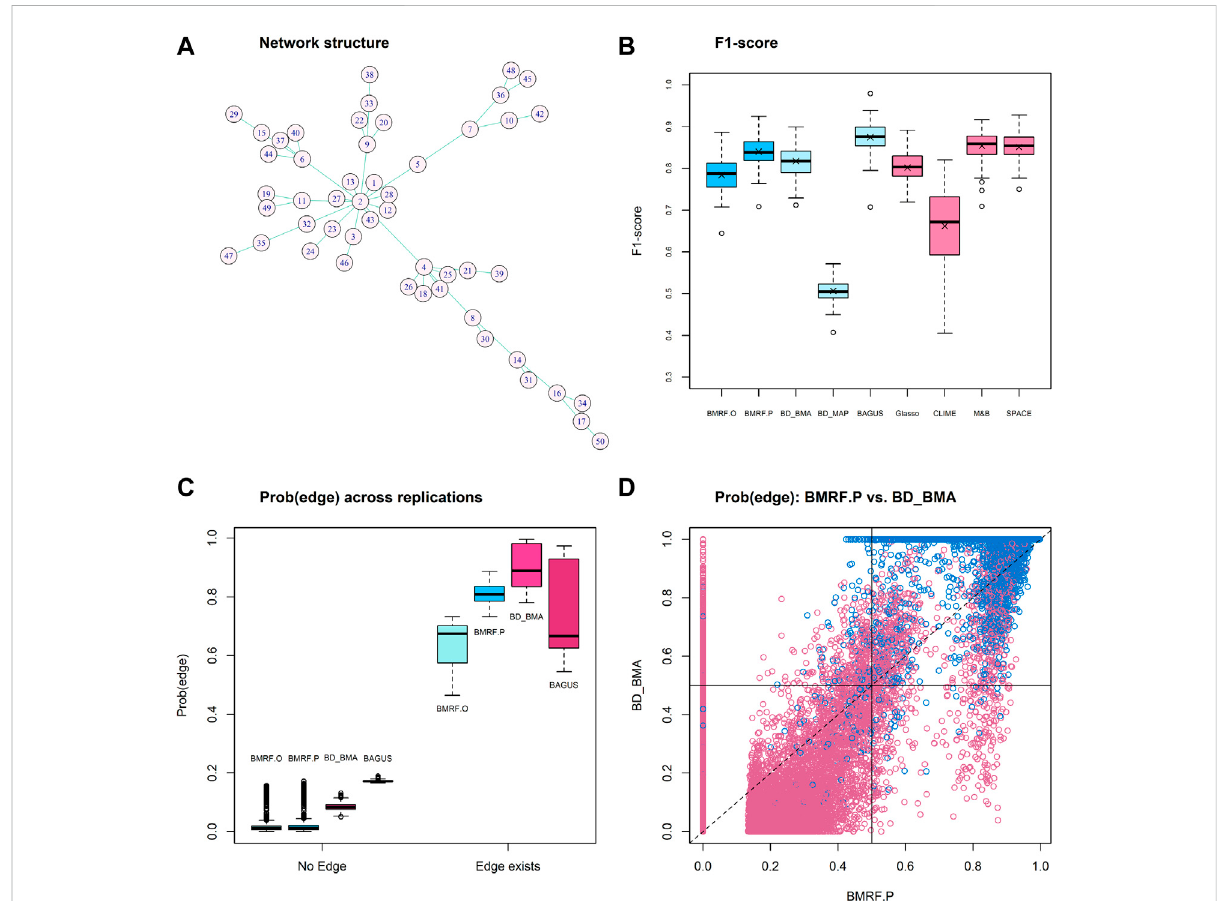
FIGURE 2 Results of competing methods under simulation setting M3. (A) The true network structure with 49 true edges; (B) Boxplots of the F1-score from 100 replications under each method; (C) Boxplots of average existence probability over 100 replications under each of the four Bayesian algorithms. The left group No Edge corresponds to the case when there is truly no edge, and the right group Edge exists corresponds to the case when the edge truly exists. Each boxplot in the right group is composed of 49 average probabilities; (D) The edge existence probability from BMRF.P versus the inclusion probability from BD_BMA for each edge across replications. Blue circles indicate true edges and red indicates no edge. The vertical and horizontal solid lines denote the cut-off values for BMRF.P and BD_BMA,